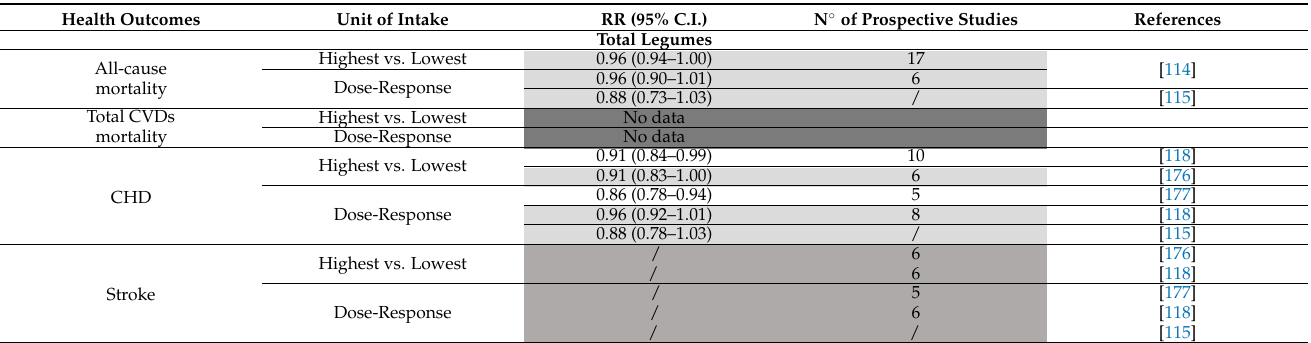
Table 7. Association between total legumes and soybean intake and incidences of some major chronic diseases/mortality of major disease groups (RR, 95% C.I.). The dose-response meta-analysis always refers to an additional serving of a food per day relative to the average intake of that food observed in a cohort study (50 g both for total legumes and